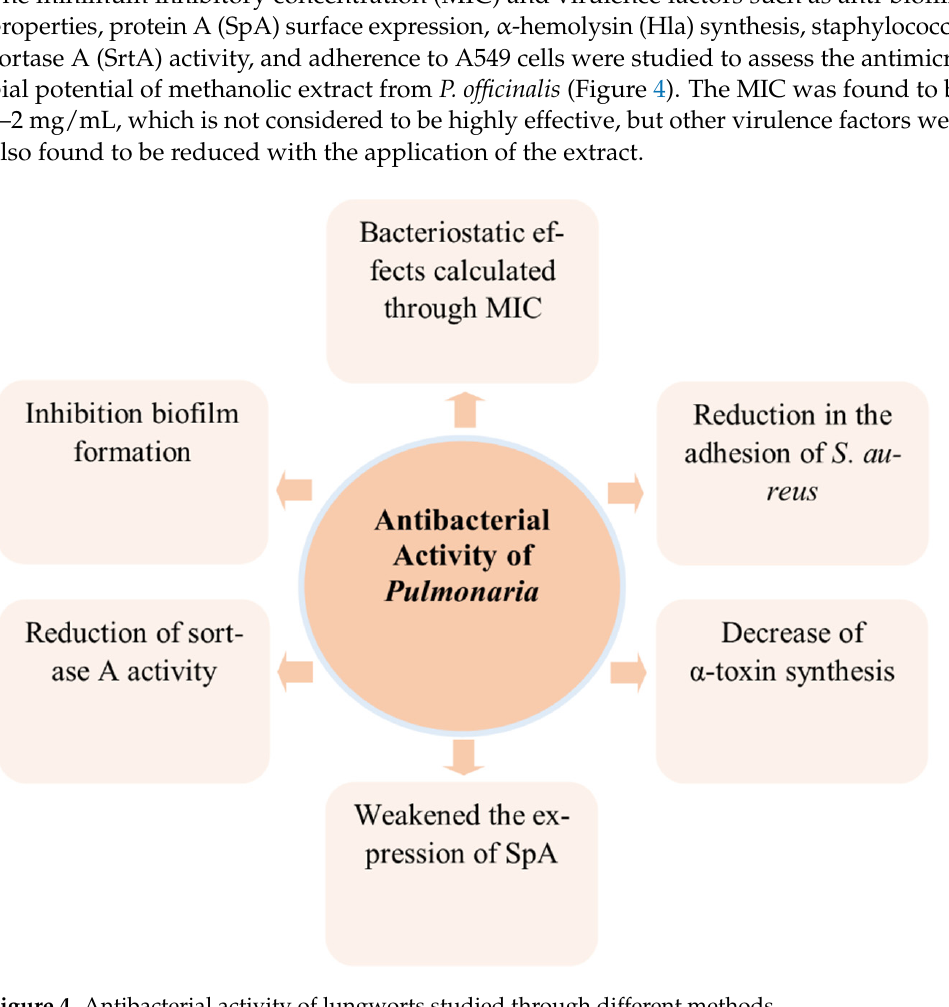
Figure 4. Antibacterial activity of lungworts studied through different methods.